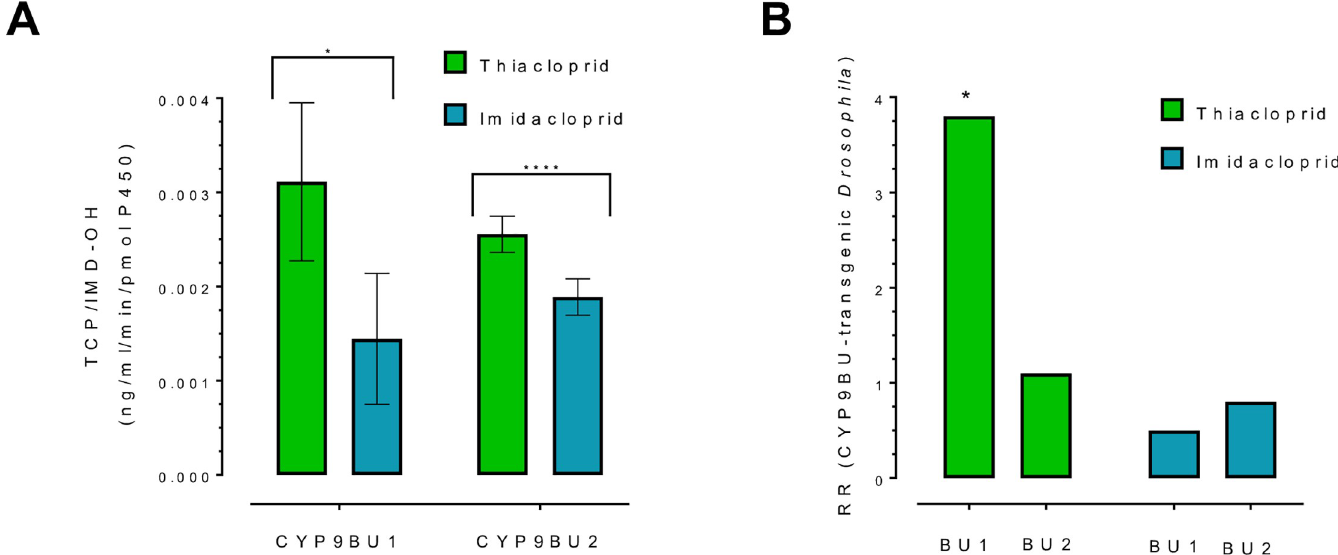
Fig 3. Identification of neonicotinoid metabolising P450s in O . bicornis . (A) Metabolism of thiacloprid and imidacloprid by recombinantly expressed CYP9BU1 and CYP9BU2. Production of 5-hydroxy thiacloprid and 5-hydroxy imidacloprid is displayed per pmol of P450 ( � P < 0.05, ���� P < 0.0001; paired t test). Error bars display standard deviation (n = 3). (B) Sensitivity of transgenic flies expressing CYP9BU1 and CYP9BU2 to thiacloprid and imidacloprid in insecticide bioassays. Data is expressed as resistance ratio (RR) compared to a control line (flies of the same genetic background but without the transgene). Significant changes in sensitivity between control and transgenic lines are indicated by an asterisk and are based on non-overlapping 95% fiducial limits of LC50 values (n = 5). See also S6 Table.